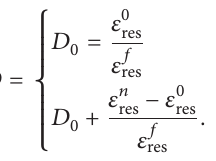
and (13). The experimental curve and the fitting curve of the three beams based on maximum fatigue strain are shown